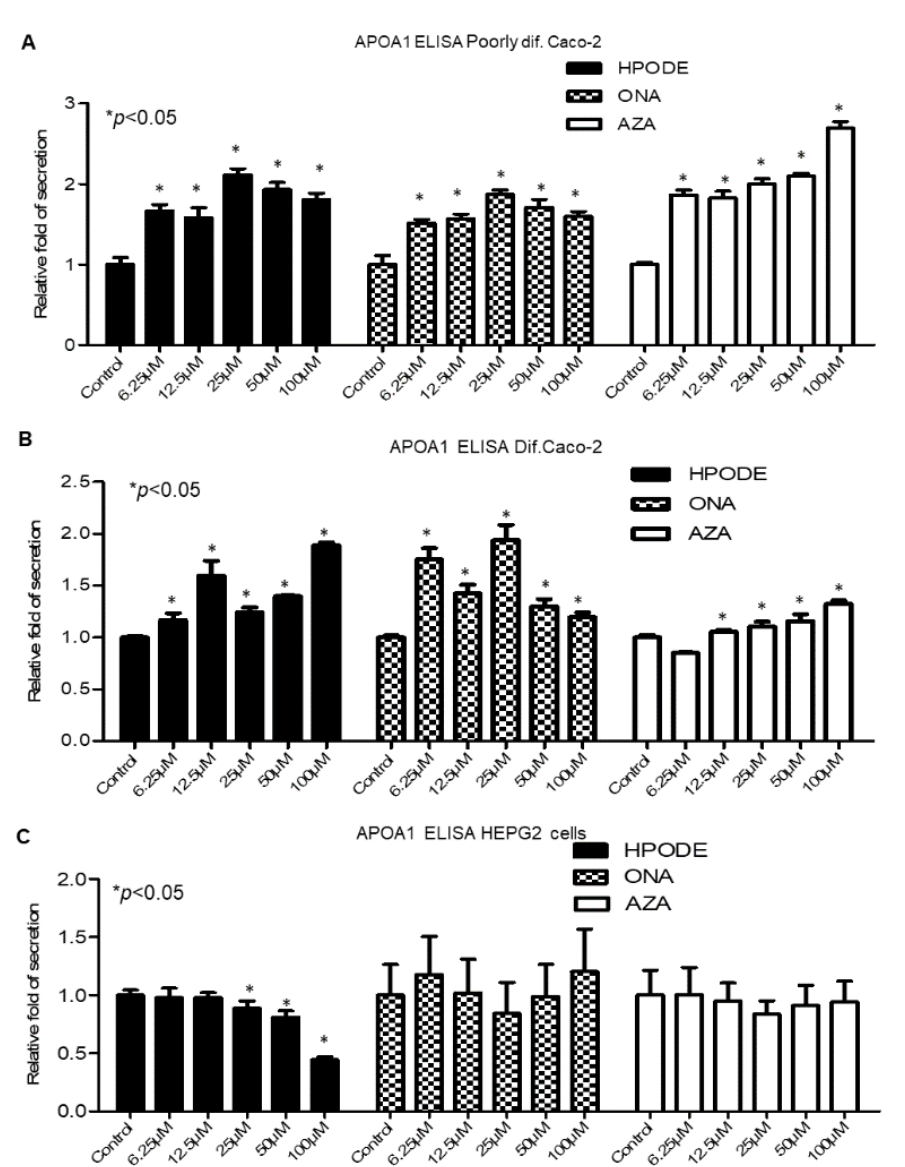
Figure 5. Caco-2 and HepG2 secretion of ApoA1 following incubation with 13-HPODE, 9-ONA and AzA for 24 h: ( A ) poorly differentiated Caco-2 cells; ( B ) fully differentiated Caco-2 cells; ( C ) HepG2 cells ( n = 9/group; * p < 0.05).